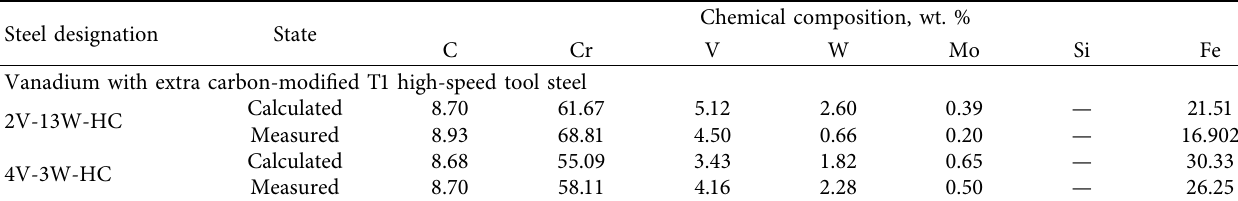
Table 6: Chemical composition of M 7 C 3 carbide for T1 high-speed tool steel and its diferent variants (as solidifed). Steel designation